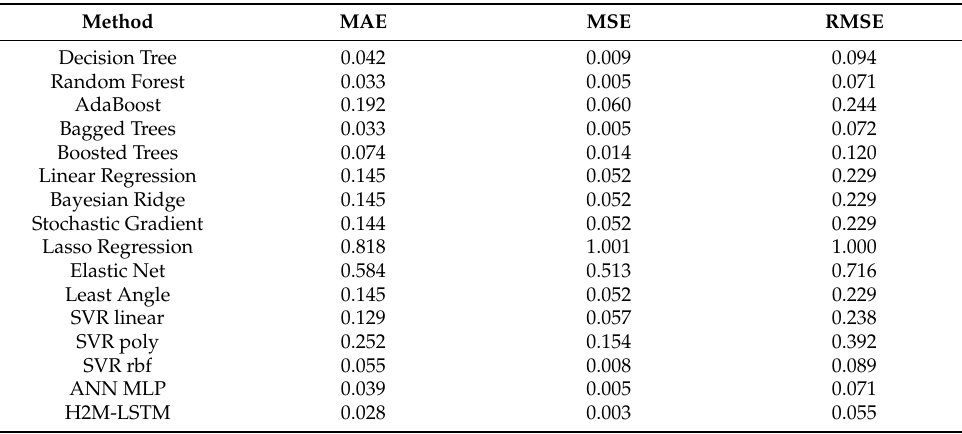
Figure 10. Barplot comparison of the best performance metrics for the heat exchanger. Table 4. Performance metrics for the heat storage tank.